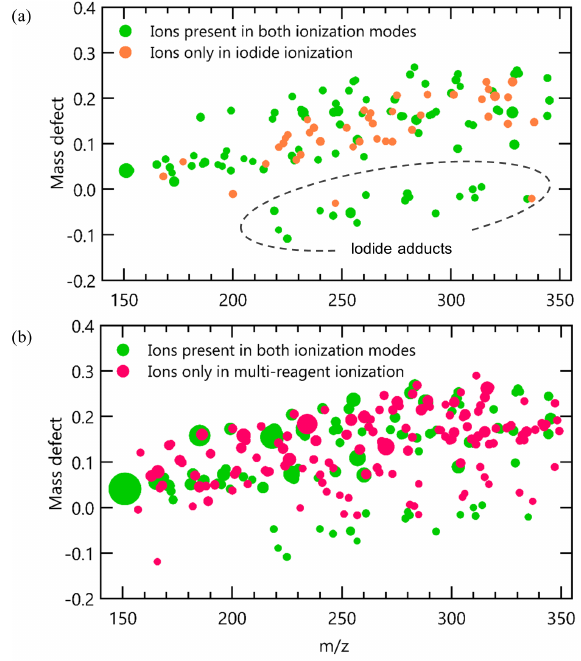
Figure 5. High-resolution mass defect spectrum obtained for liq- uid mixture samples in (a) iodide ionization mode and (b) multi- reagent ionization mode. The area of markers is proportional to the ion